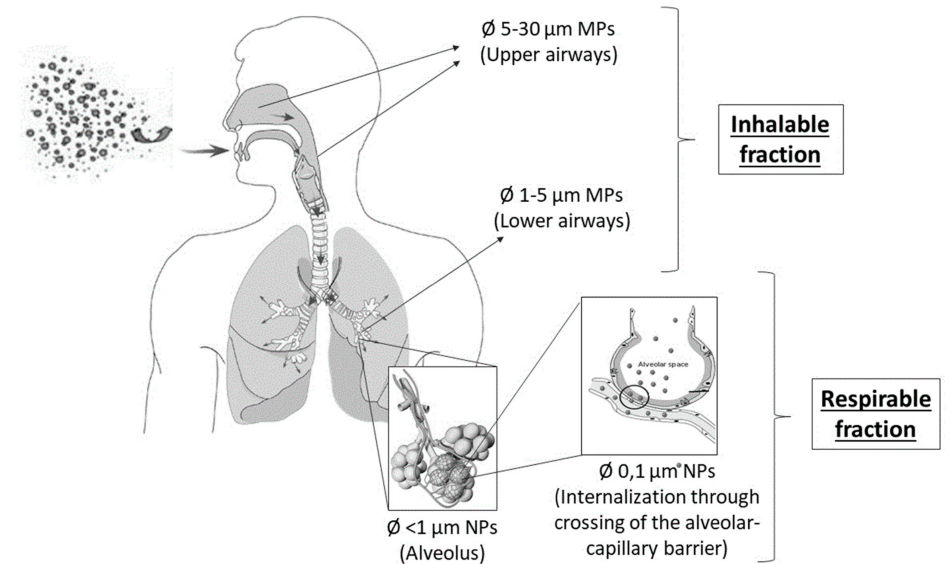
Figure 1. Size-selective inhalation of airborne microplastics involves specific regions of the respiratory tract: inhalable fraction (upper and lower airways) and respirable fraction (deep